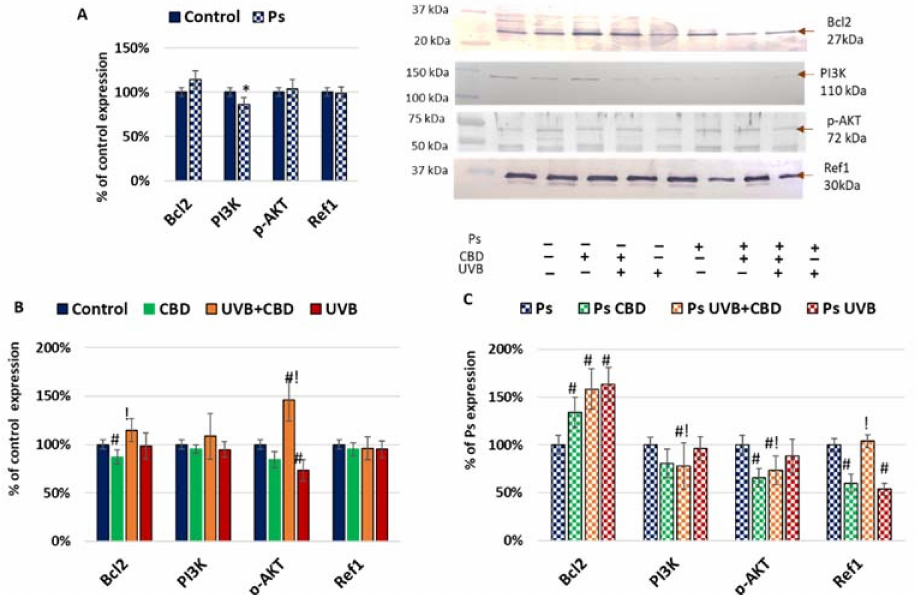
Figure 2. ( A ) Expression of apoptosis inhibitors in keratinocyte cell lines from healthy subjects (Control; n = 5) and psoriatic patients (Ps; n = 5). Here, 100% corresponds to the level of protein in healthy keratinocytes untreated with UVB or CBD. The mean values ± SD are presented with statistically significant differences: * between keratinocytes from patients with psoriasis vulgaris and healthy subjects, p < 0.05. ( B ) Expression of apoptosis inhibitors in keratinocyte cell lines from healthy subjects (Control; n = 5) without treatment and after irradiation with UVB (60 mJ/cm 2 ) and/or incubation with CBD (4 µ M). Here, 100% corresponds to the level of protein in healthy keratinocytes untreated with UVB or CBD. The mean values ± SD are presented with statistically significant differences: # between keratinocytes treated with CBD, UVB and UVB+CBD and nontreated, p < 0.05; ! between keratinocytes treated with UVB+CBD and irradiated with UVB, p < 0.05. ( C ) Expression of apoptosis inhibitors in keratinocyte cell lines from psoriatic patients (Ps; n = 5) without treatment and after irradiation with UVB (60 mJ/cm 2 ) and/or incubation with CBD (4 µ M). Here, 100% corresponds to the level of protein in keratinocytes untreated with UVB or CBD. The mean values ± SD are presented with statistically significant differences: # between keratinocytes treated with CBD, UVB and UVB+CBD and nontreated, p < 0.05; ! between keratinocytes treated with UVB+CBD and irradiated with UVB, p <